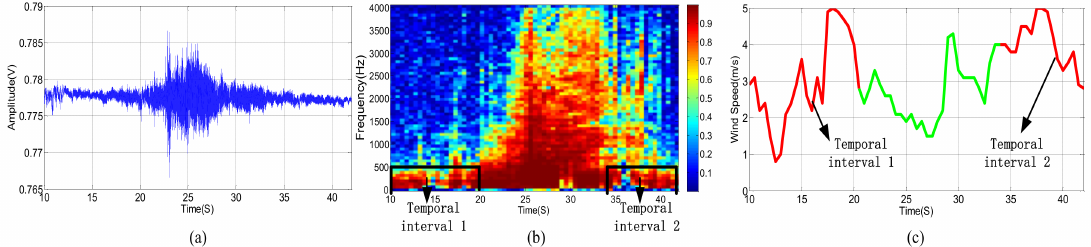
Figure 12. ( a ) Acoustic signal of a car passing the microphone array at level 4 wind power. ( b ) The sub-band correlation of ( a ). ( c ) Wind speed situation of ( a